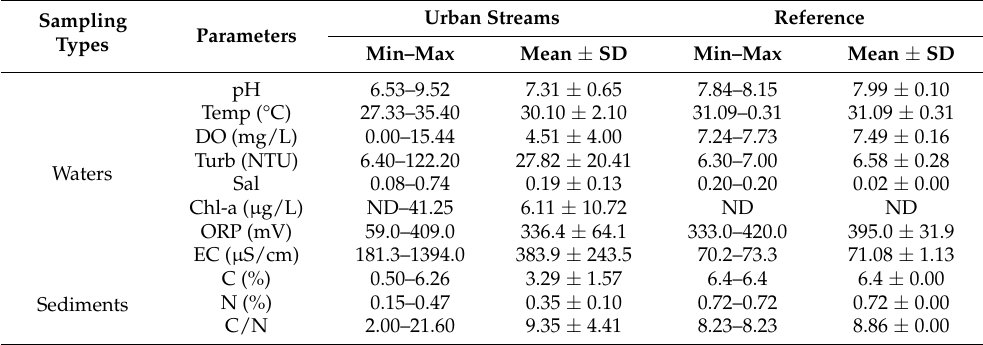
Table 1. Biogeochemical parameters of water and sediment samples in urban streams and the